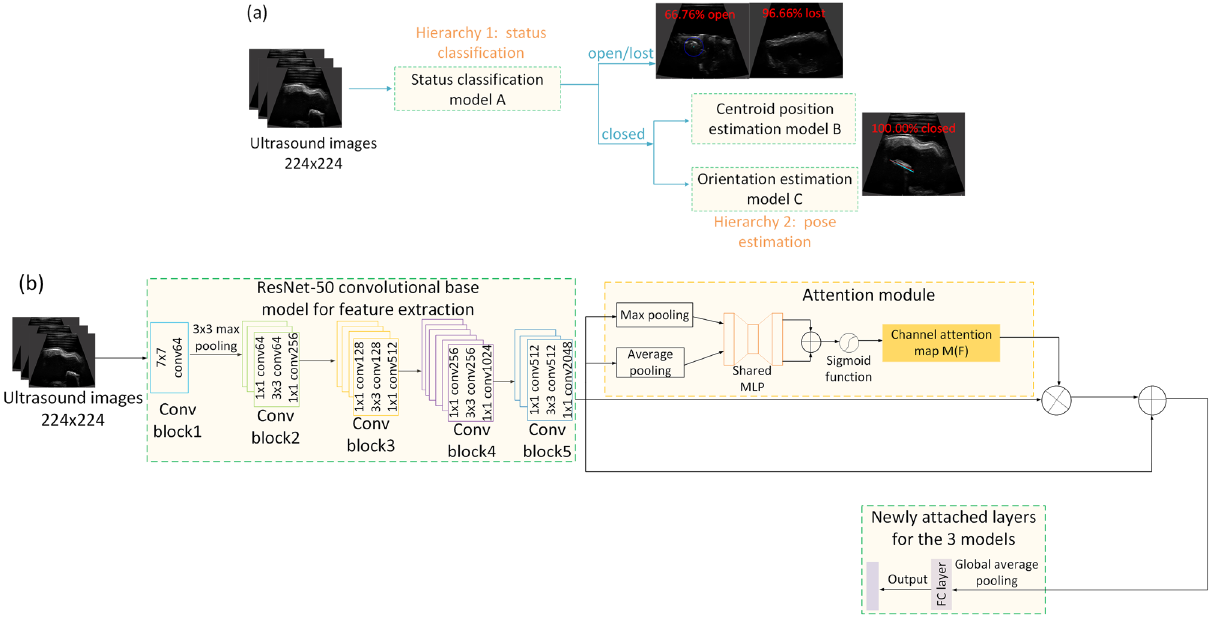
α β ( 1 − α) · c x − β · c y obtained by I R = I × R . The rotation matrix R is defined as , where α = c · cos θ , − β α β · c + ( 1 − α) · c (cid:31) x y (cid:30) β = c · sin θ , with θ ∈ [ 0 ◦ , 5 ◦ ] being the rotation angle, c x and c y are the coordinates around which the image is rotated, c is a scale factor to resize the image after rotation. In our work, c x = w 2 and c y = h 2 are defined as the image center, and c = 1 . In order to generate a balanced dataset while not distorting the images, the data aug- mentation strategy was applied to complement the dataset with small missing angles and further expand the 1 0 t x dataset. We also expanded the base dataset by shifting each image I using the defined translation matrix 0 1 t y (cid:30) , (cid:31) where t x ∈ [− 10, 10 ] and t y ∈ [− 10, 12 ] are the pixels by which the image to be shifted along x - and y - axis while ensure the integrity of the capsule in the shifted images (Supplementary Fig. S2d). Black borders resulted from the rotation and shift were cropped to avoid the neural network using these black borders as features during the training process (Supplementary Fig. S2c,e). These new images (with accordingly shifted and rotated pose labels) and the base dataset images constitute an augmented dataset with a size of 52,620 images, which consists of 24230 and 28390 for 2D pose estimation and state detection, respectively. During training, we split the two training datasets into train, validation, and test set with a ratio of 7:2:1. Attention‑based hierarchical neural network. We proposed an attention-based hierarchical model to simultaneously detect the state and estimate the 2D pose of the capsule robot in US frames. The integration of the attention module can increase feature representation power, allowing the model focus on target features while suppress background noise. The workflow is shown in Fig. 6a, where Model A first performs state classification; if the detected state is closed, Model B and C for the 2D pose prediction are triggered and provide orientation and center point position estimations. Otherwise, the model detects the capsule as an “open” or “lost” state. Instead of training one model for multiple tasks, three models are trained separately for the mechanism state classification, centroid position, and orientation estimations using different training hyperparameters, including fine-tuning depths, learning rate and training epochs, to obtain optimal performances for different tasks. The three models have a similar architecture, which consists of the pre-trained ResNet-50 40 residual blocks for feature extraction, an attention module, a global average pooling (GAP) layer, and a fully-connected (FC) output layer with either a regression or classification output in the desired dimensions, as shown in Fig. 6b. We adopt ResNet because it solves the optimization difficulty of vanishing gradient for training deep neural networks and obtains faster convergence and accuracy gains from increased depth. Consider the l -th convolutional block in the pre-trained ResNet model: